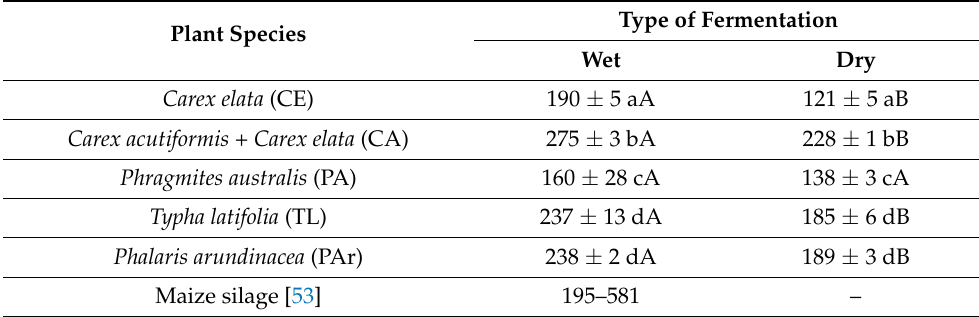
Table 3. Methane production (NL kg VS − 1 ) of wetland plants, harvested in September 2019.